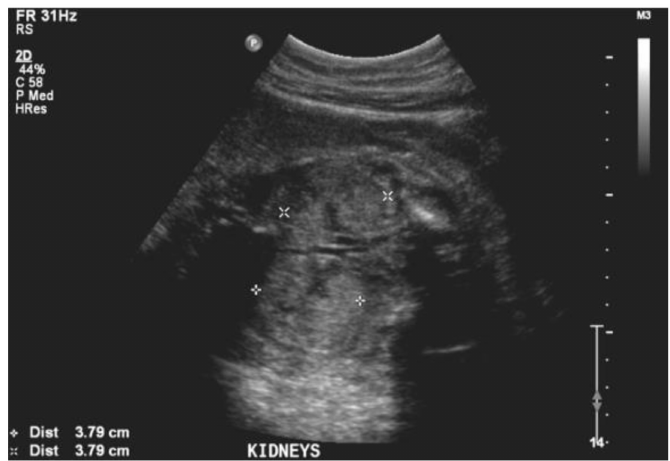
Figure 1. Ultrasound image of fetal kidneys at 27 weeks of gestation.